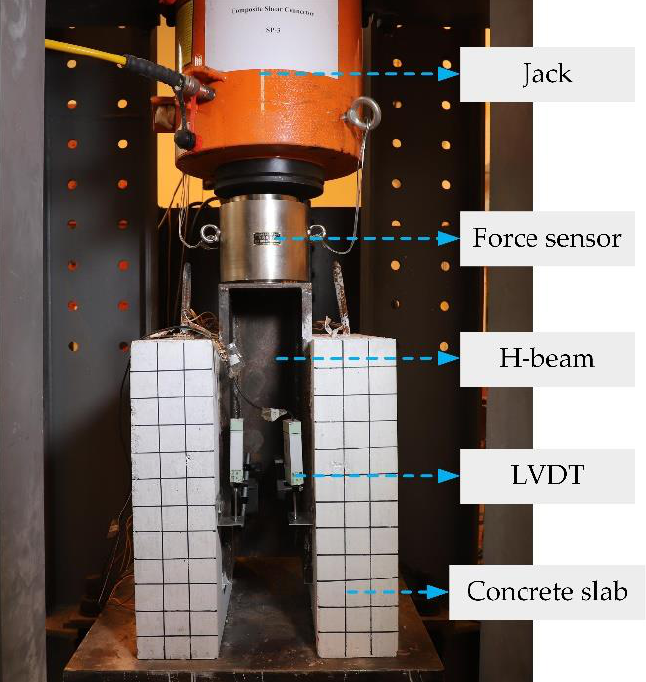
Figure 4. Loading equipment and measurements.